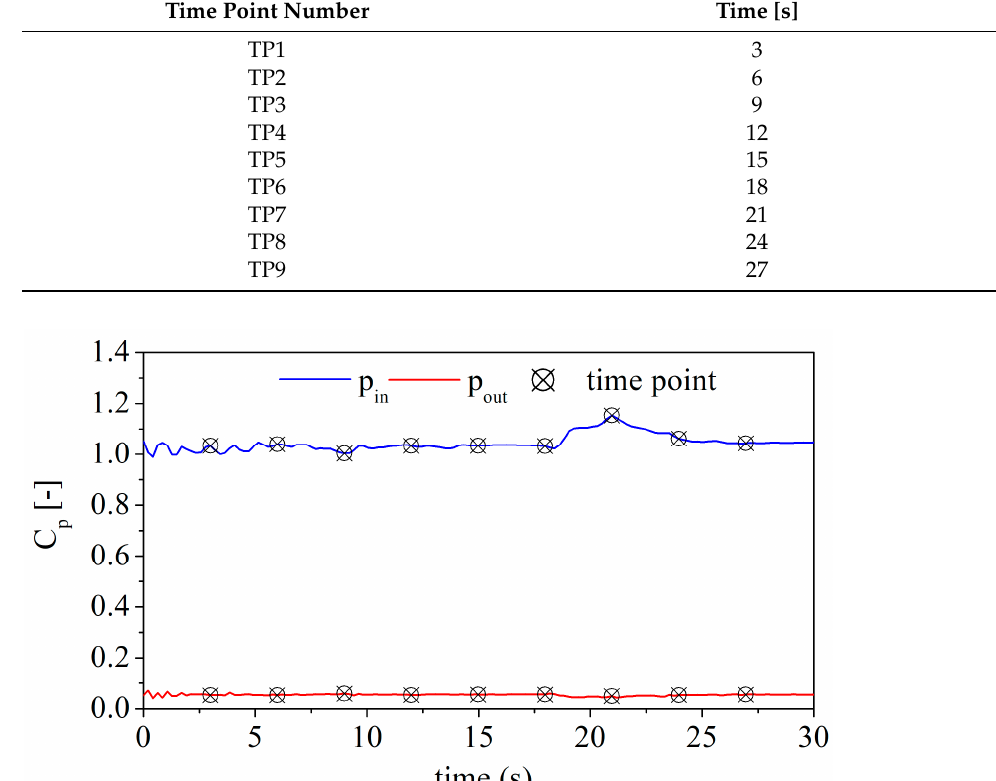
Figure 7. The inlet and outlet boundary conditions. Table 1. Time points.